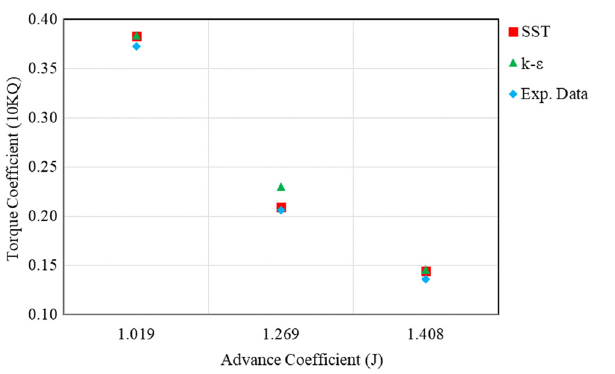
Figure 12: Numerical results of thrust coe ffi cient ( K T ) of Zwart Cavitation Model.